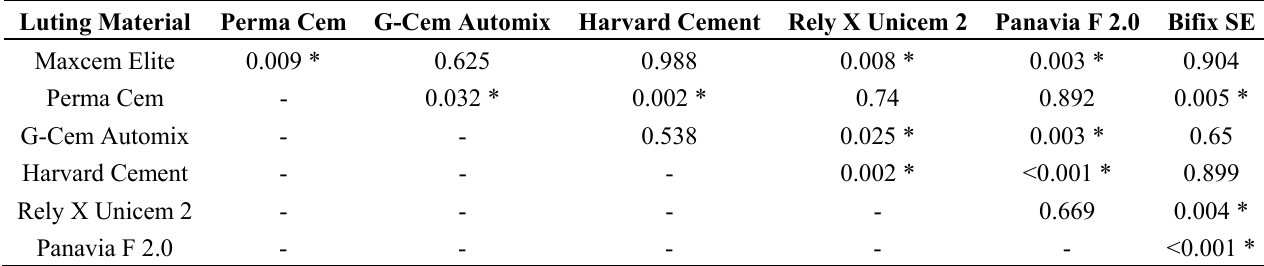
Table 5. P -values of the microleakage between the different luting materials in enamel. Luting